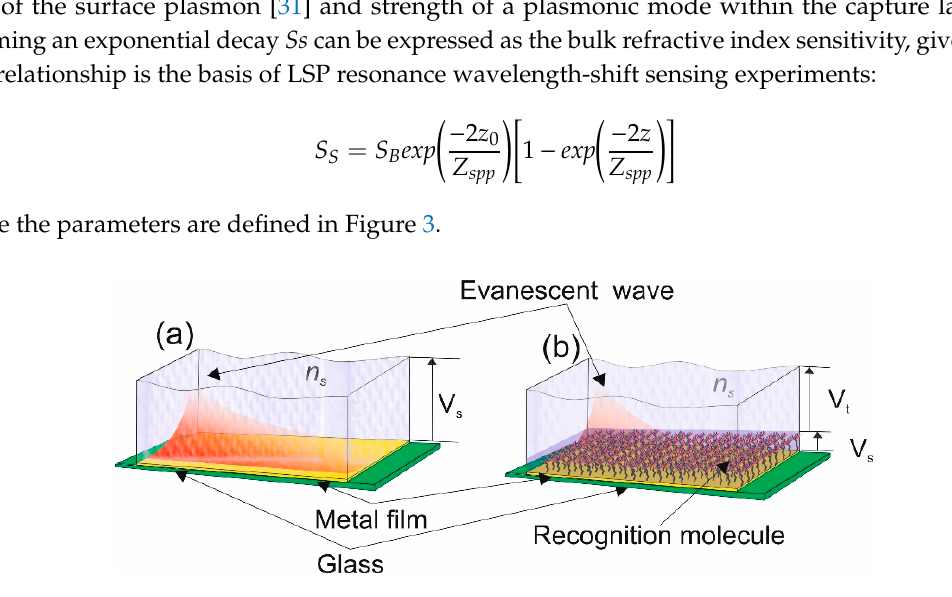
Figure 2. Conceptual illustration of the sensing volume and sensing coverage. (a) The full use of the evanescent wave of the surface plasmon to detection of bulk chemical changes in solution. (b) the partly use of the evanescent wave of the surface plasmon working in conjunction with recognition molecule adhered to the metal film for specific molecule detection